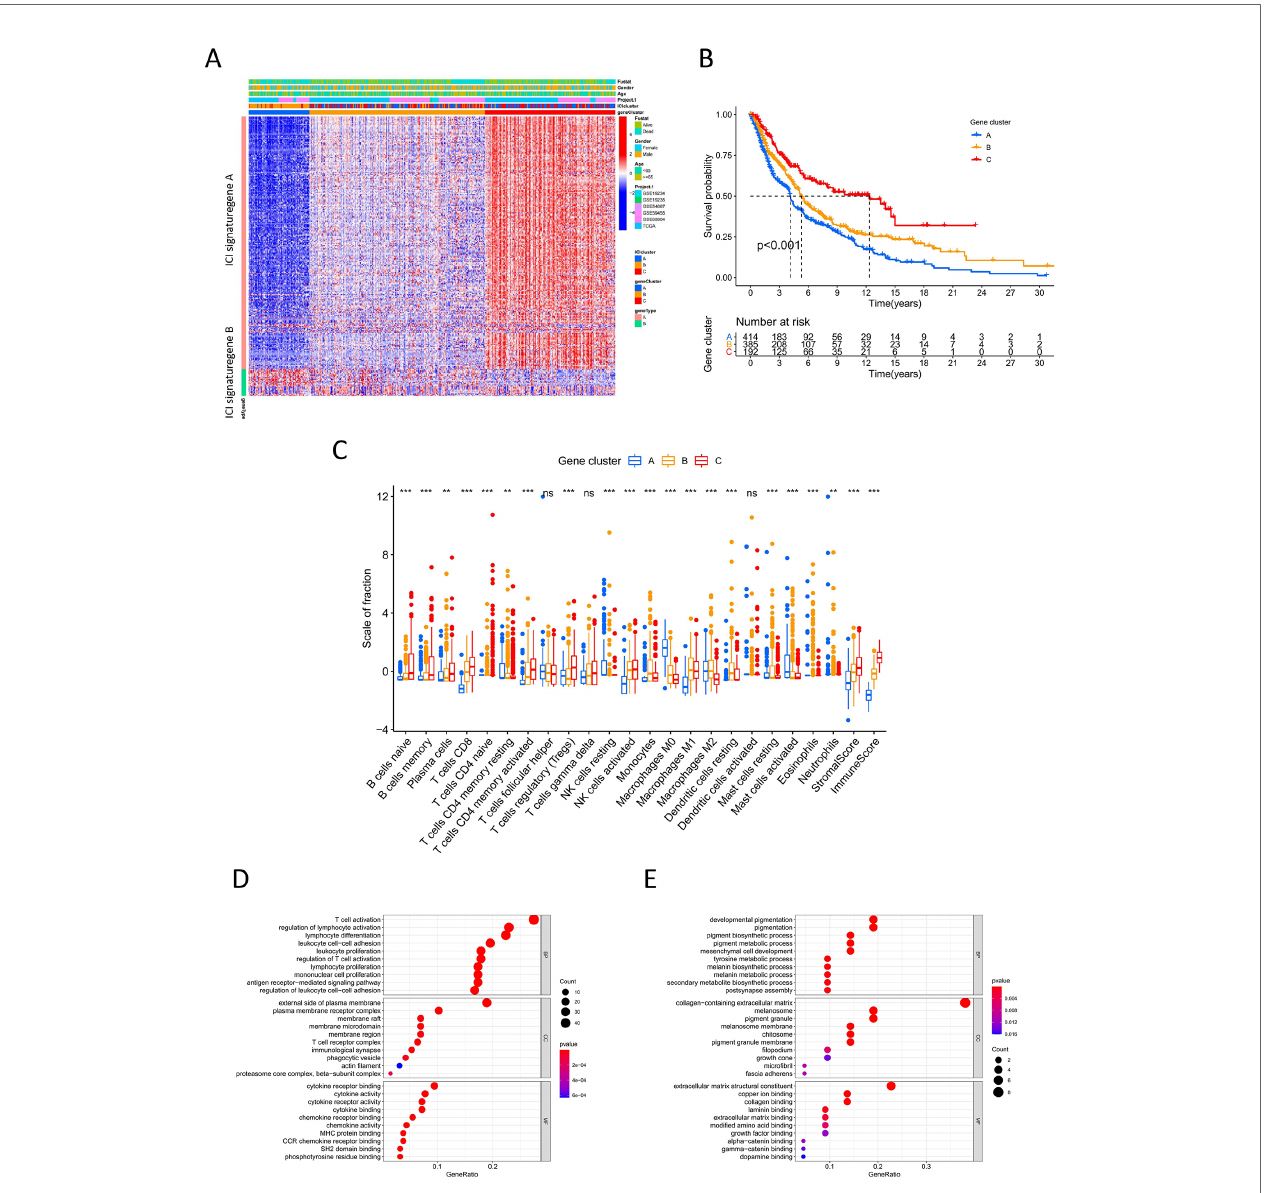
FIGURE 2 | Immune gene subtype (A) Unsupervised clustering heatmap of differential expression genes among three ICI cluster. (B) Kaplan-Meier curves of overall survival for gene cluster A-C. Log rank test P <0.001. (C) The box plot of immune cells fraction in gene cluster A-C. **P < 0.01; ***P<0.001; ns, no signi fi cance. (D, E) GO enrichment analysis for ICI signature gene A and